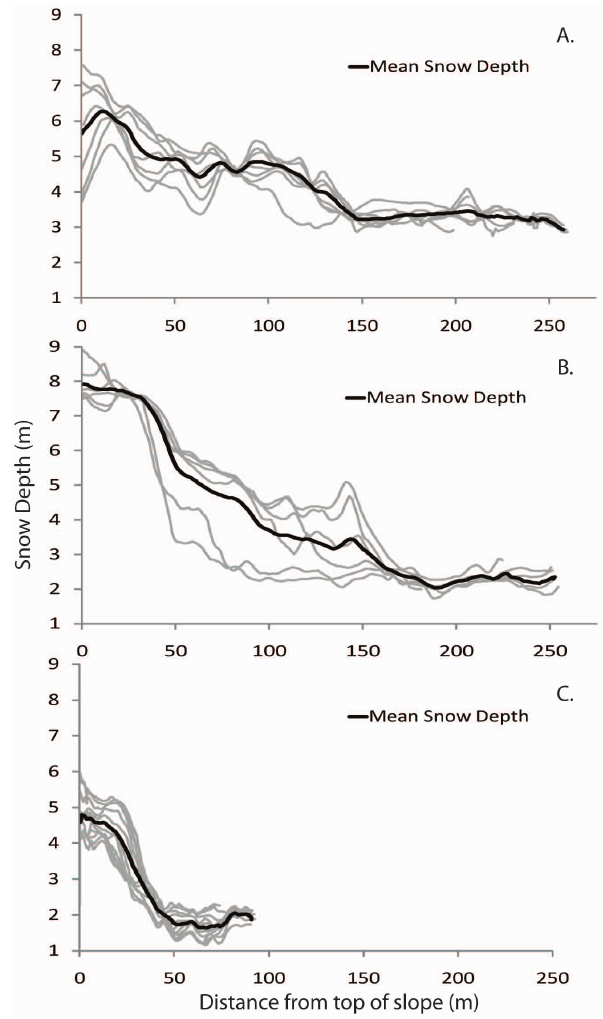
Fig. 8. Profiles of snow depth accumulation (A) lower talus, 2008, (B) lower talus, 2009, (C) upper talus, 2008. Grey lines are ex- tracted snow depth profiles. Black lines are the mean snow depths of the extracted snow depth